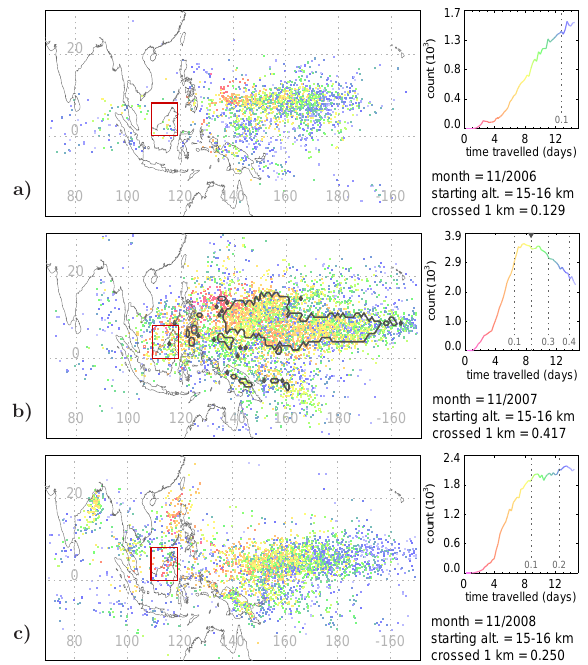
Fig. 4. As for Fig. 1 but focussing on trajectories started between Fig. 4. As for figure 1 but focussing on trajectories started between 12–13 km for the Novembers of 2006, 2007 and 2008. 12–13km for the Novembers of 2006, 2007 and 2008. Fig. 5. As for figure 1 but focussing on trajectories started between 15–16 km for the Novembers of 2006, 2007 and 2008.